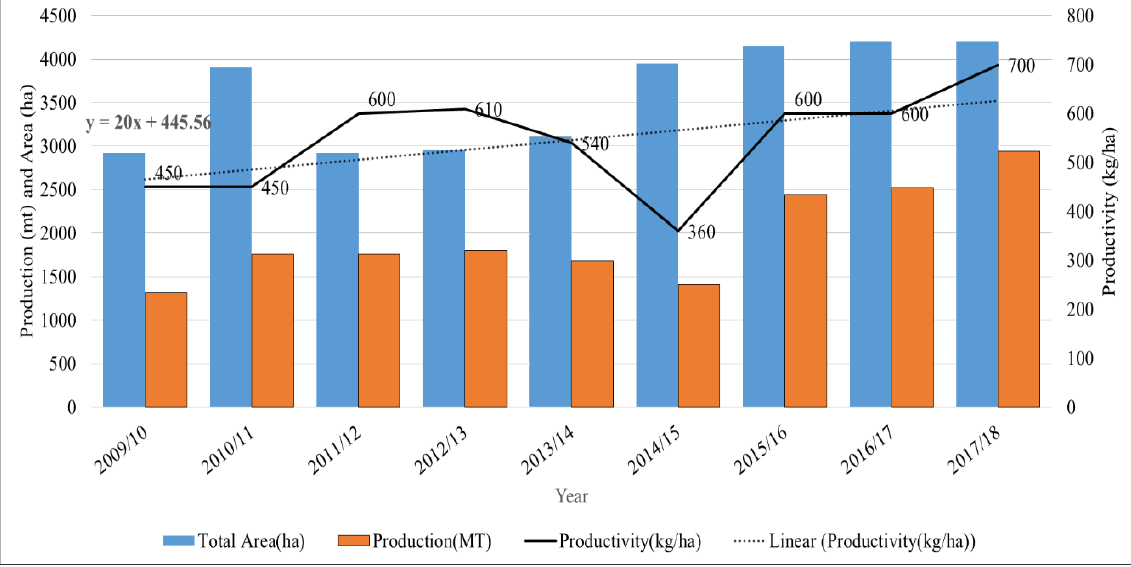
Figure 1 Area, production and productivity of large cardamom in Taplejung District (Source: DADO Taplejung (F.Y.